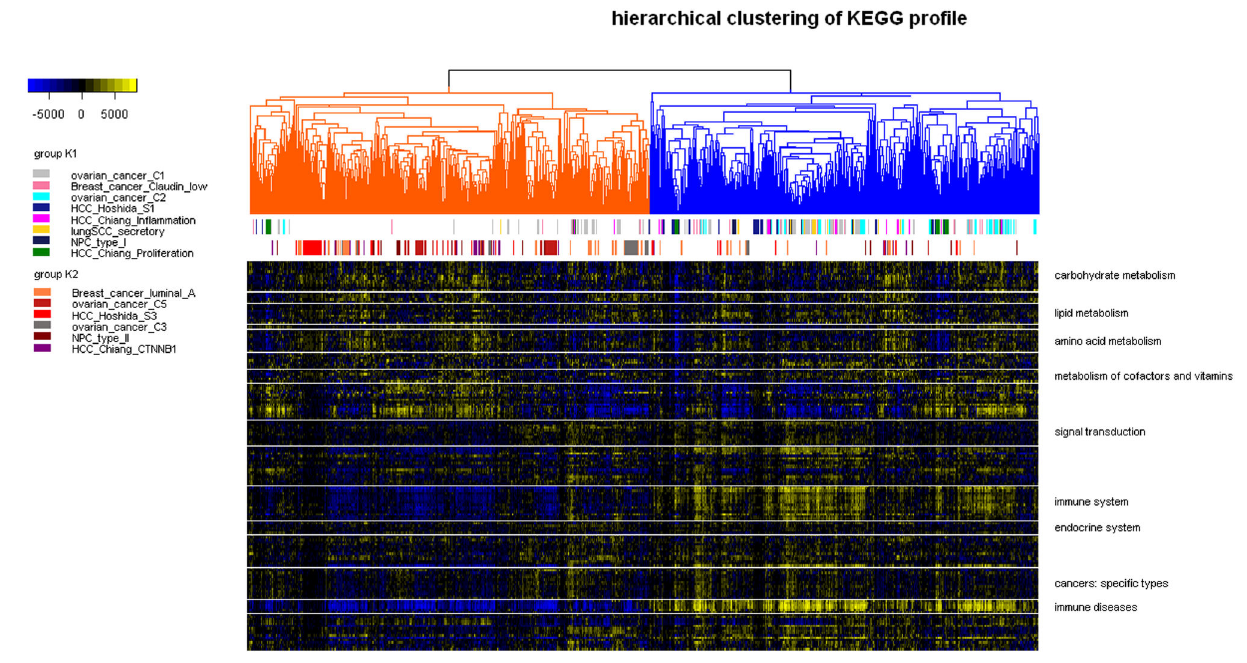
Figure 3. Pathway profiles across six human cancers. . Each grid represents a score of pathway activity calculated by single- sample GSEA. No further adjustment of the ssGSEA score was performed. Pathways were ordered by category manually and separated from others using horizontal white lines. Only categories with more than five pathways were labeled. The dendrogram was split into two groups with group K1 colored by blue and group K2 colored by orange. The upper horizontal color bar marked subtypes overrepresented in group K1 while the lower horizontal color bar marked subtypes overrepresented in group K2. Most subtypes were significantly enriched (p-value < 0.05, Chi-squared test) except HCC Chiang’s Proliferation and CTNNB1 (p-value = 7.27e-02 and 7.86e-02,